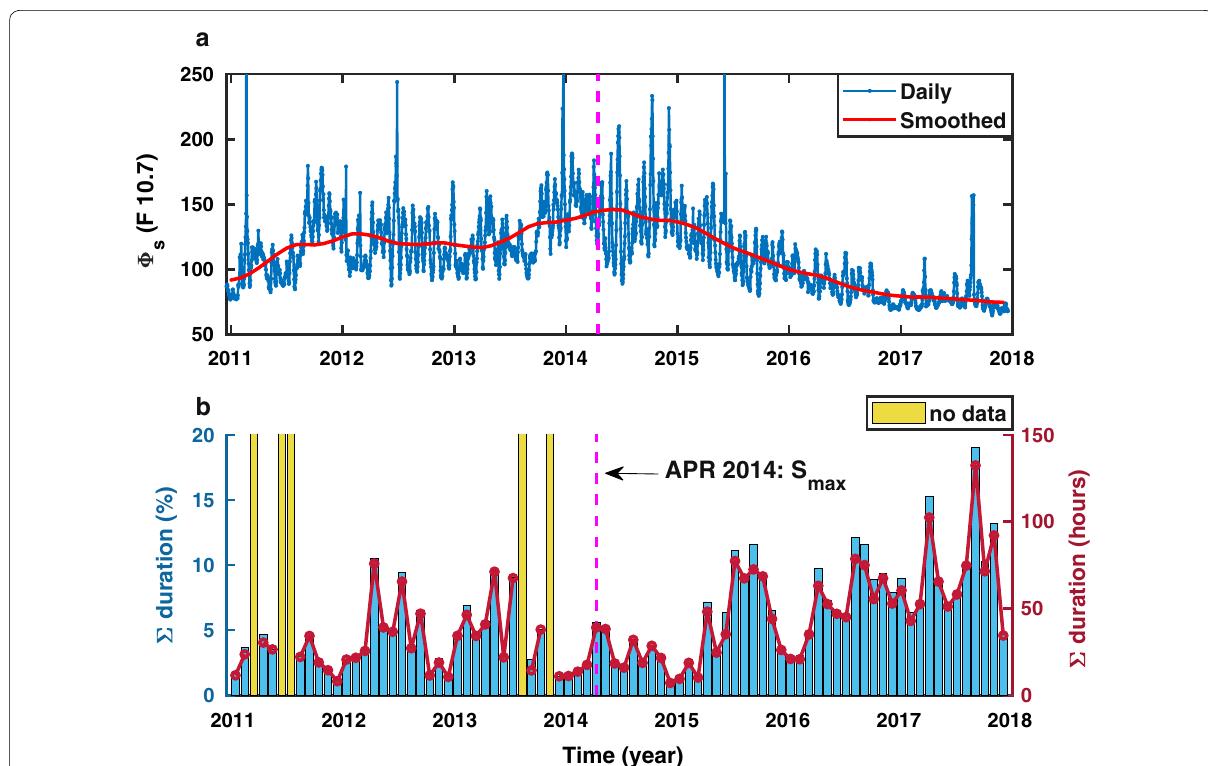
Fig. 4 a The daily F10.7 cm solar flux ( � s ) as a function of time superimposed with their 13-monthly smooth averaged values for 2011–2017. The unit of 10.7 cm solar flux is 10 − 22 Wm − 2 Hz − 1 . b The monthly percentage of duration (left Y -axis) and the monthly duration in hours (right Y -axis) of EMIC waves. The months where data loss is large (exceeds 30%) are marked by yellow bars. The peak of solar cycle 24 occurred during April 2014, which is marked by vertical dotted line in each panel. This line divides the total dataset into ascending and descending